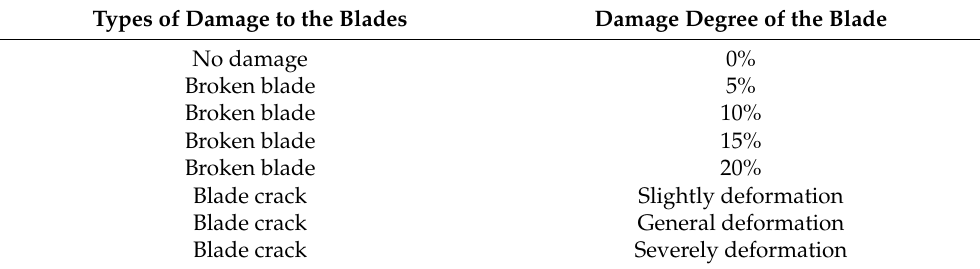
Table 1. Main types and degrees of